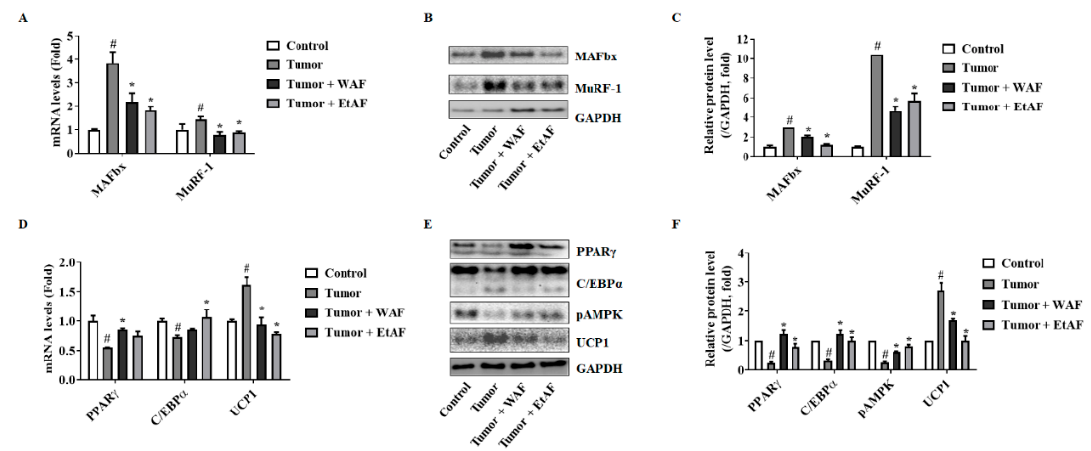
Figure 4. Effects of AF in gMuscle and eWAT from CT-26 tumor-bearing mice. mRNA levels of MAFbx and MuRF-1 in gMuscle ( A ). The proteins levels of MAFbx and MuRF-1 ( B ) and relative levels ( C ) in gMuscle. The mRNA expression levels of PPAR γ , C/EBP α , and UCP1 in eWAT ( D ). The protein levels of PPAR γ , C/EBP α , pAMPK, and UCP1 in eWAT ( E ). The relative protein expression levels of eWAT ( F ). GAPDH was used as an endogenous control. All values are mean ± SD. # p < 0.05, significantly different from control group; * p < 0.05, significantly different from tumor group.